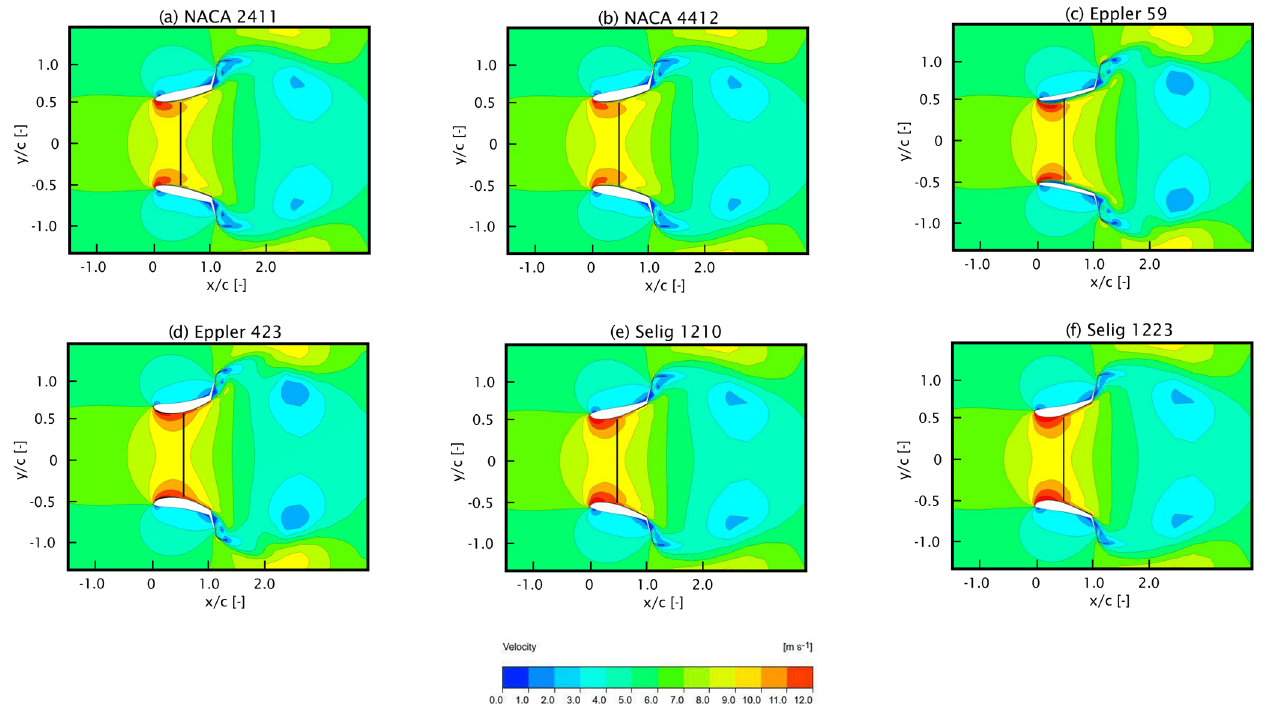
Figure 7. Velocity contours of the streamwise normalized velocity. The results depict performance of the stage 3 airfoils at C T = 0 . 767.